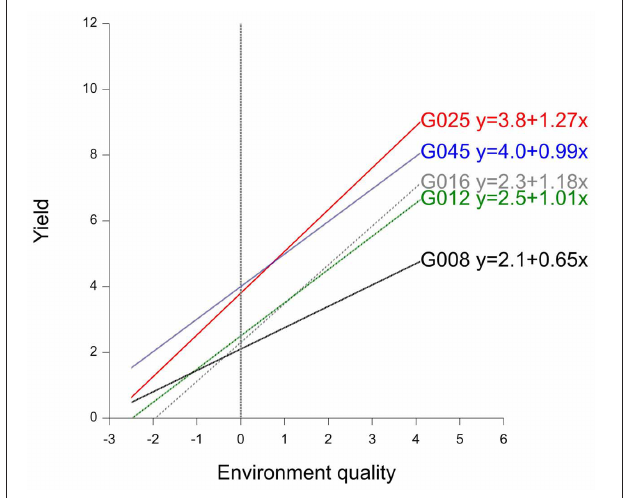
FIGURE 3 | Finlay–Wilkinson regression curves of five maize genotypes. The vertical line indicates the average environment. Next to genotype labels, the corresponding Finlay-Wilkinson regression equation is